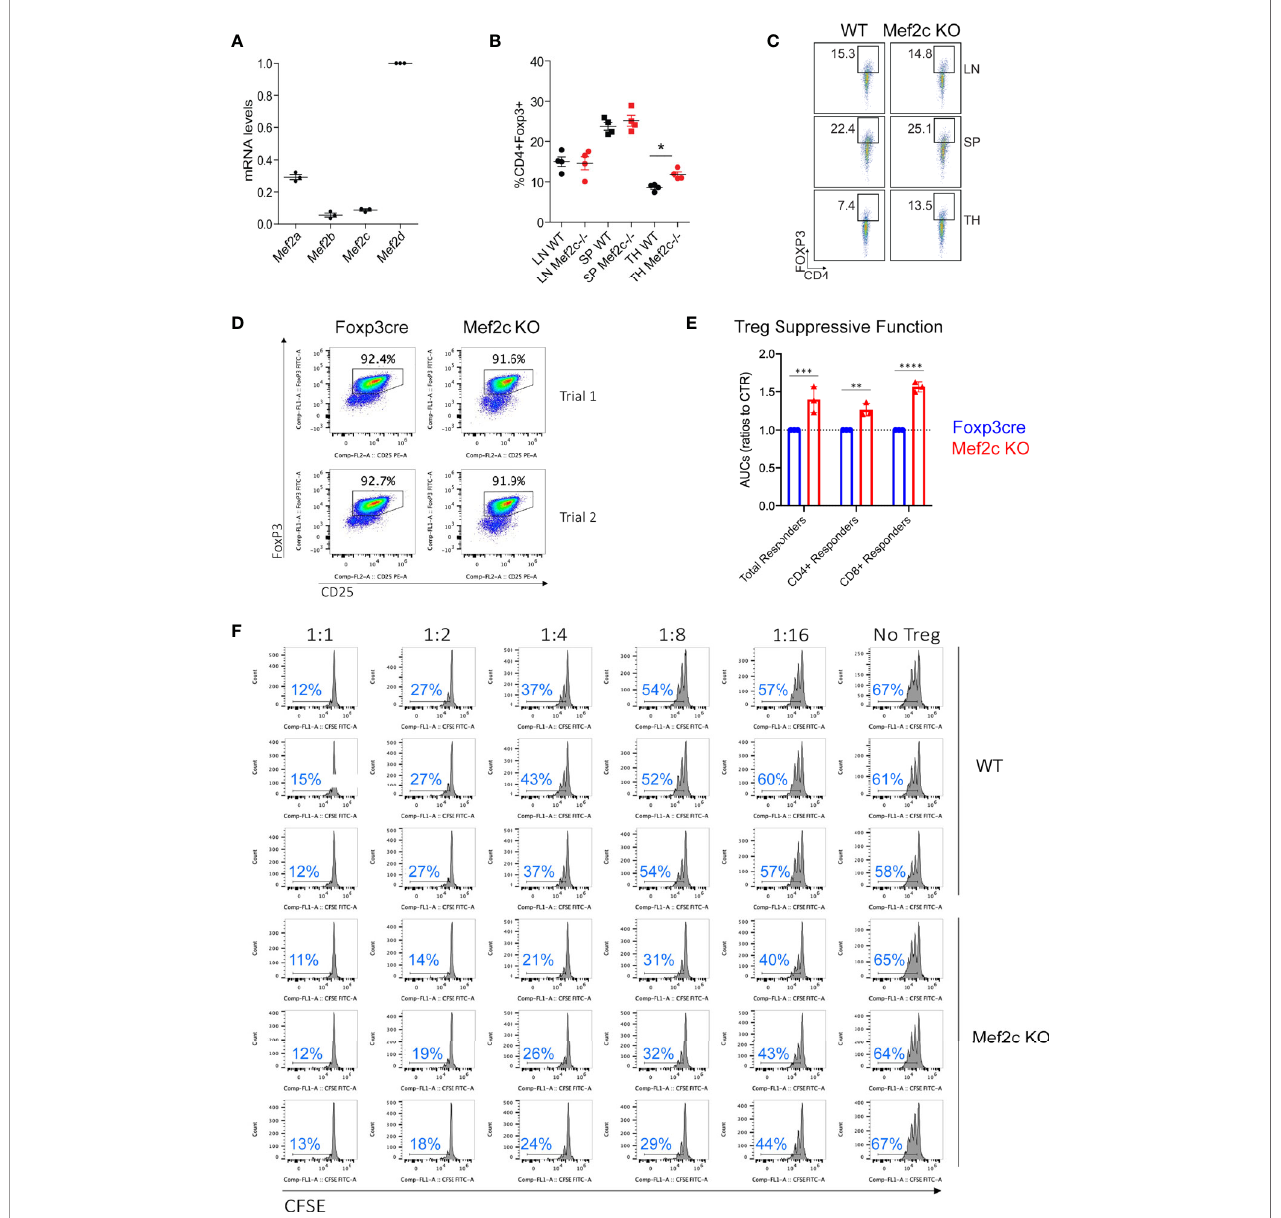
FIGURE 1 | Mef2c deletion in Tregs increases their suppressive properties in vitro . (A) mRNA absolute levels of the indicated Mef2 paralogues in Tregs, expressed as RPKM levels relative to Mef2d levels. (B, C) Analysis of CD4+Foxp3+ in lymph nodes (LN), spleens (SP) and thymii (TH) tissues from Mef2c-/- or WT mice (n = 4, *p < 0.05, t-test). (D) Purity of CD4+CD25+Foxp3+ Tregs used for Treg assays (representative of 3 mice/group) and performed twice (Trial 1 and Trial 2). (E) AUC data from Treg suppression assays performed twice and in triplicate (**p < 0.01, ***p < 0.005, ***p < 0.001). (F) Examples of Treg suppression assays performed in triplicate and using all T cells as proliferating cells (separate CD4 and CD8 T cells responses are shown in Supplementary Figure 1 ); the proportion of proliferating T cells within each panel is shown in